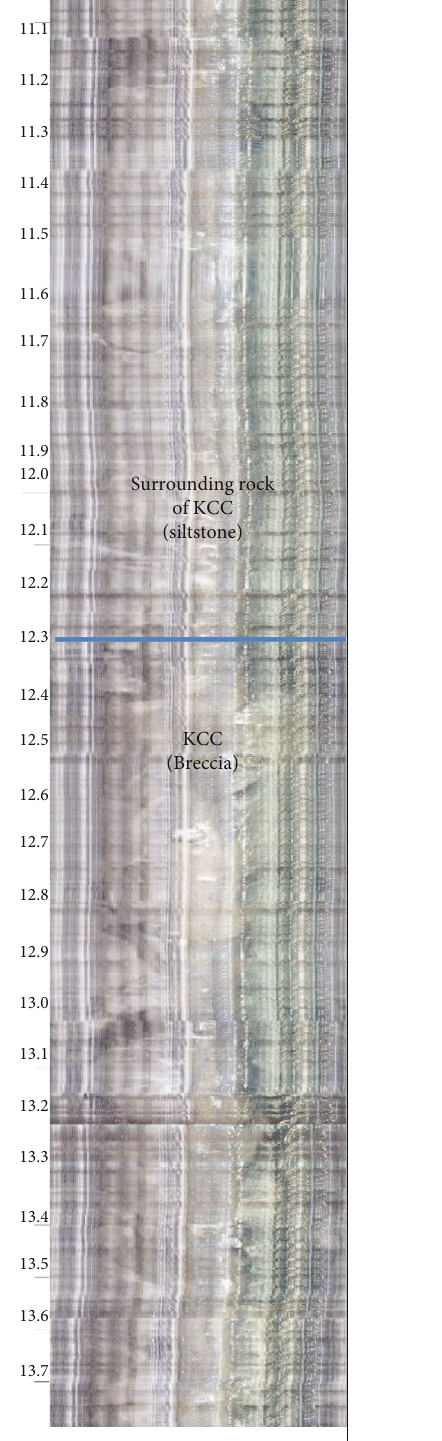
Figure 5: Television image of KCC